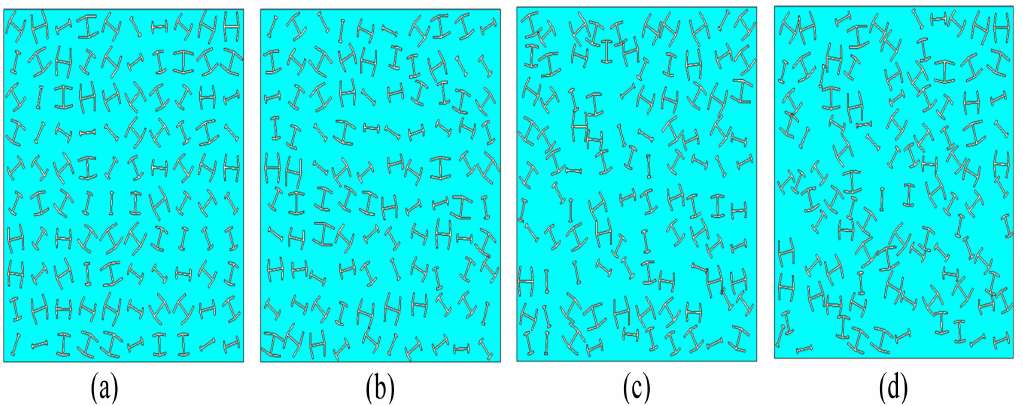
Figure 14. Coding and location both random ( a ) metasurface 1; ( b ) metasurface 2; ( c ) metasurface 3 and ( d ) metasurface 4.